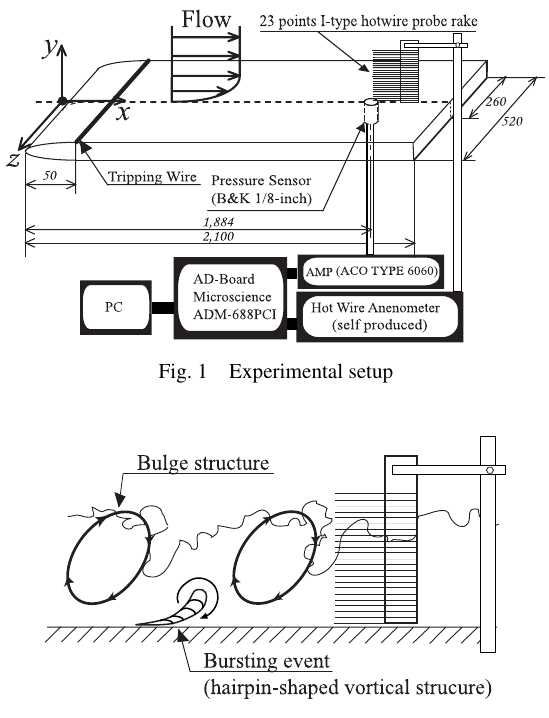
Fig. 2 Schematic of bulge structure and bursting event (not to